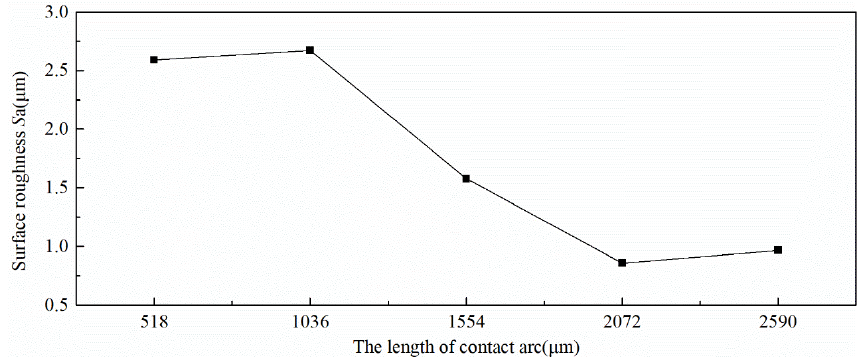
Figure 6. Change of the S a in contact arc zone.